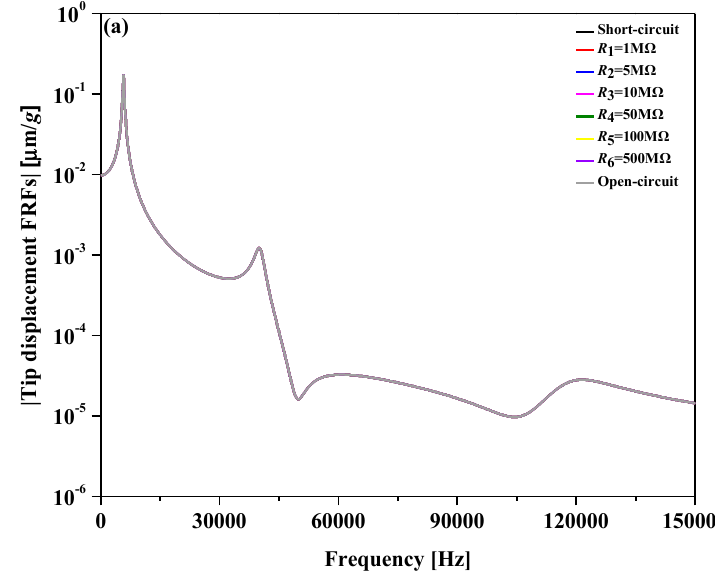
Appl. Sci. 2019 , 9 , x FOR PEER REVIEW Figure 5. Tip displacement FRFs of the 3 μm thickness beam for the first three modes. Figure 5. Tip displacement FRFs of the 3 µ m thickness beam for the first three modes.